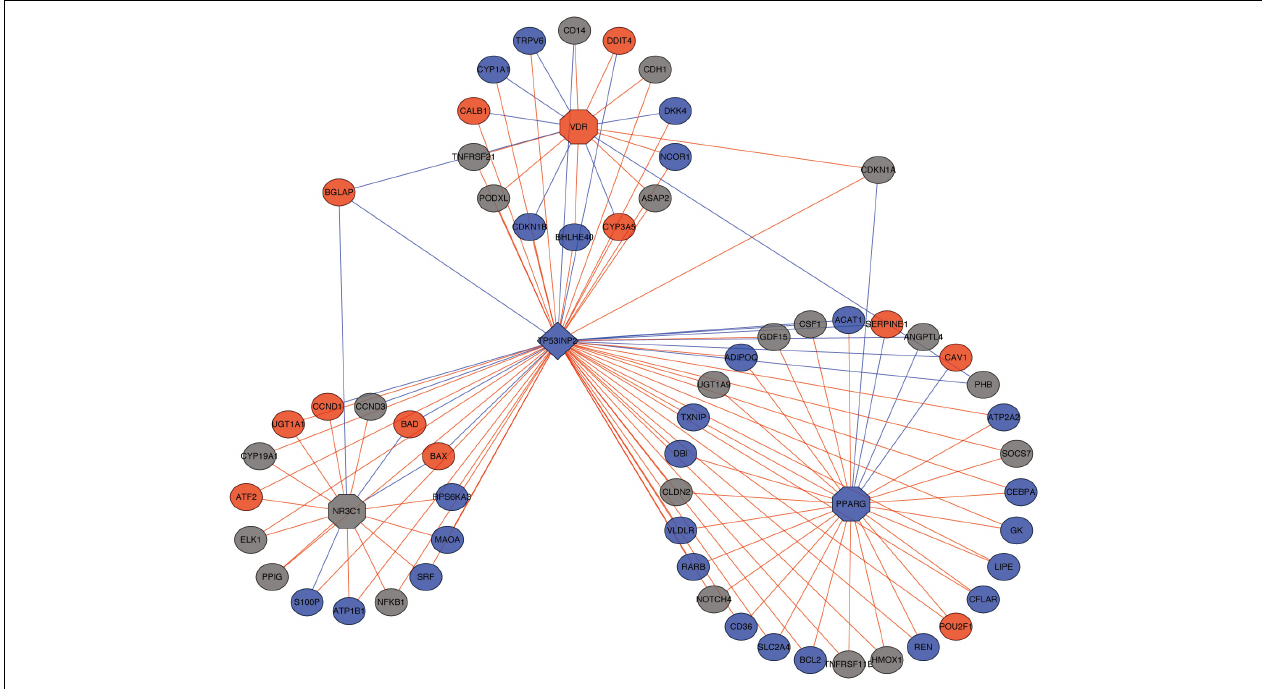
FIGURE 3 | The network of TP53INP2 and targeted genes of nuclear hormone receptors. Red dot represents up-regulated targeted genes; blue dot represents down-regulated targeted genes; red line represents positive correlation; blue line represents negative correlation.